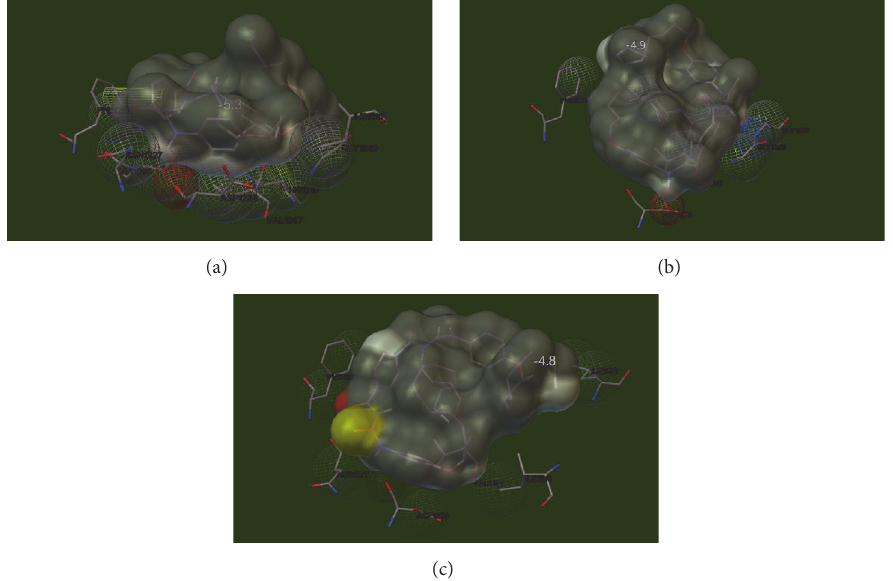
Figure 3: The molecular binding of (a) 2a , (b) 2b , and (c) 2c with enzyme enoyl ACP reductase (FabI) of E. coli .